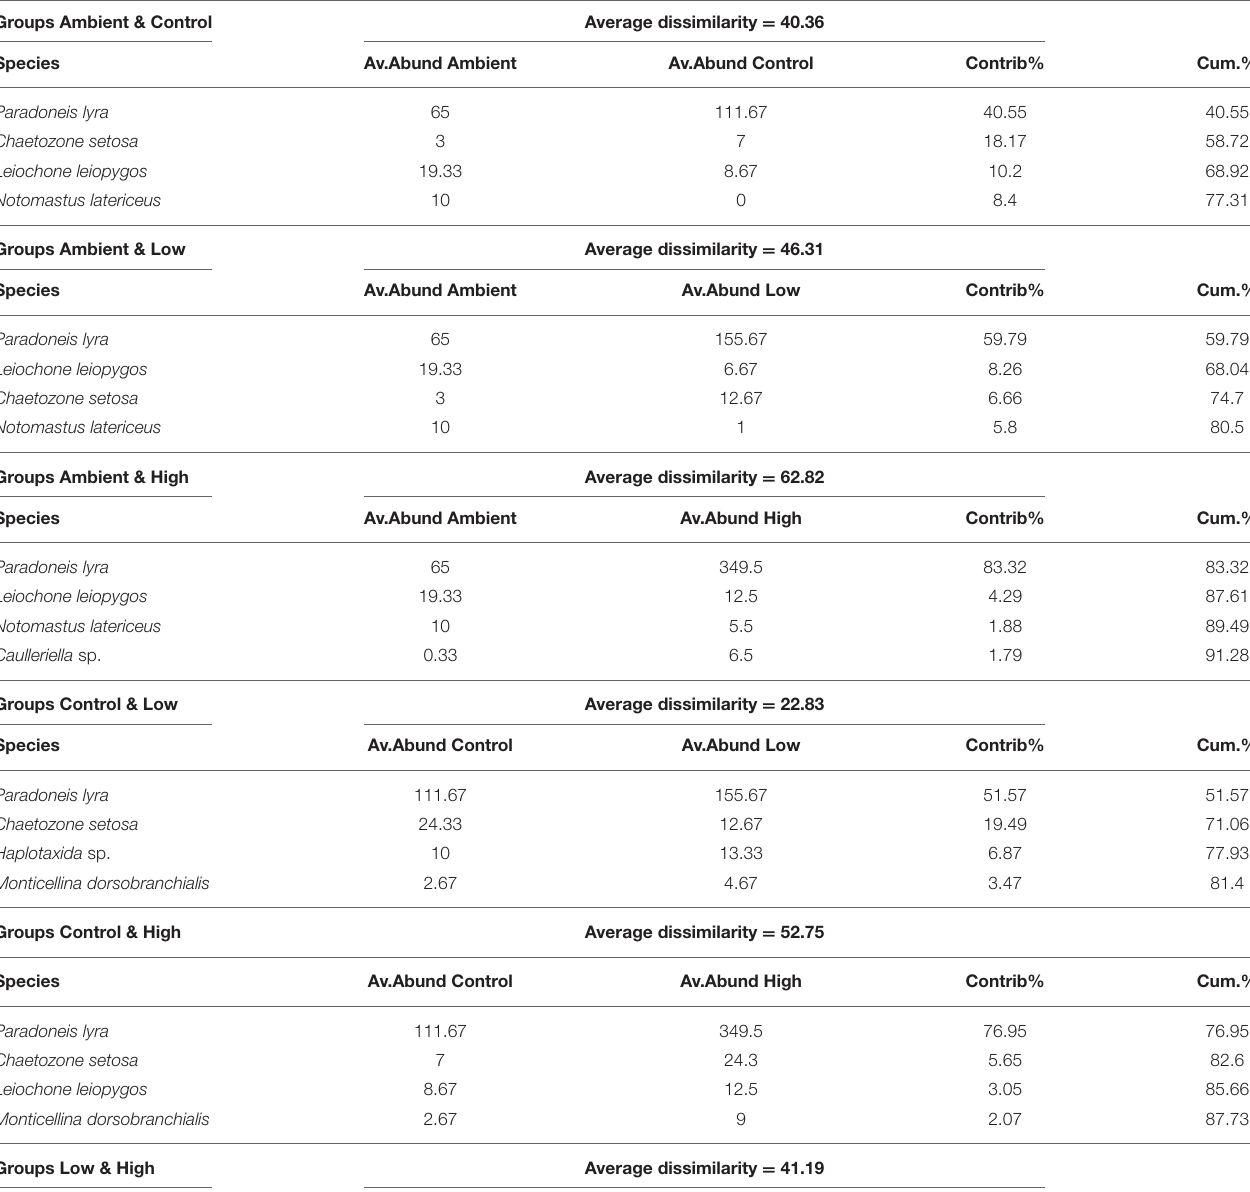
TABLE 3 | SIMPER analysis results between groups of samples (Ambient, Control, Low eutrophication, High eutrophication) of macrofaunal data. Groups Ambient & Control Average dissimilarity =